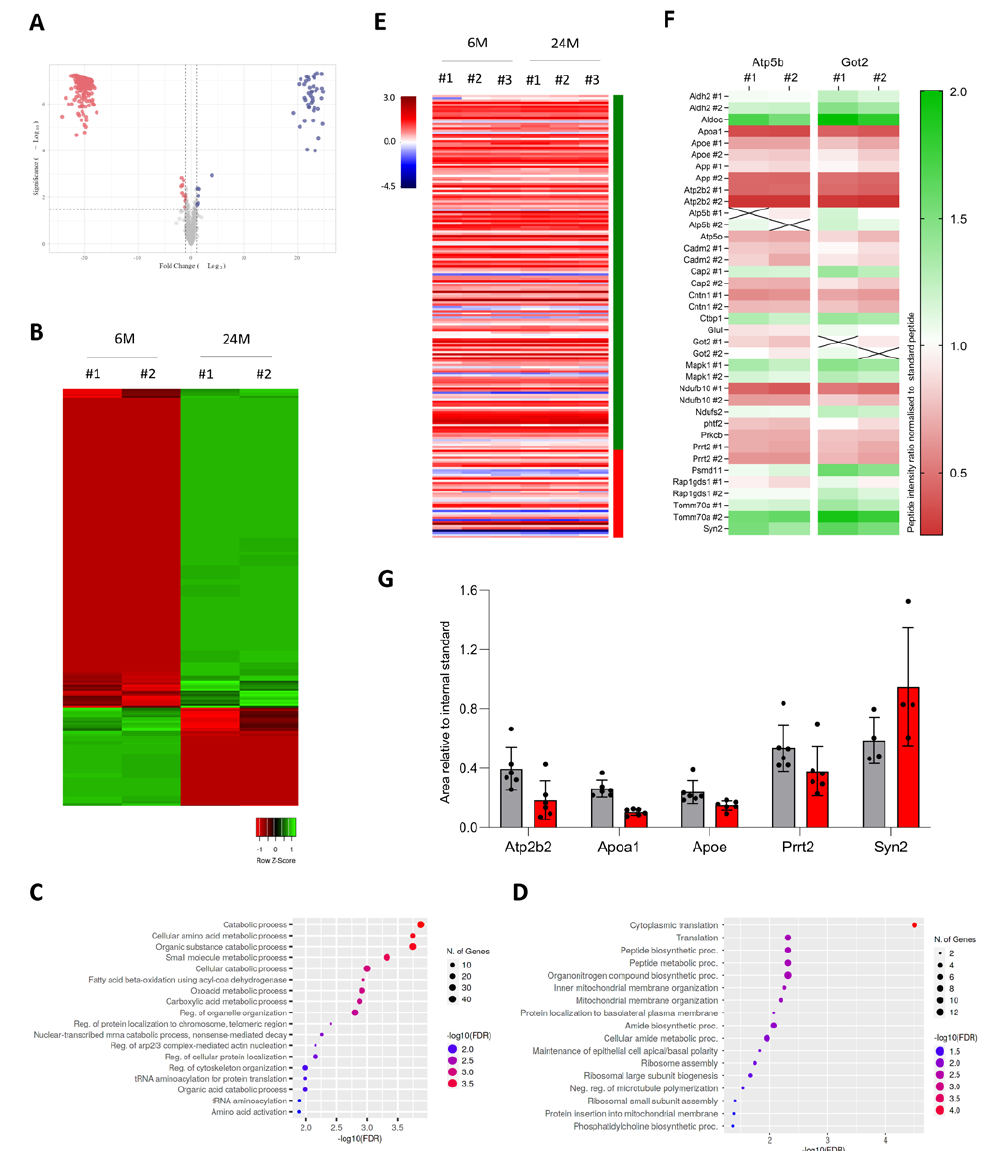
Figure 4. Age-related changes in the proteome of the cerebral cortex. ( A ) Volcano plot of the distribution of differentially enriched proteins, mapping the 164 down-regulated proteins (red) and 42 up-regulated proteins (blue). Data analysis was performed using Prostar software (log2 fold change threshold: 1, –log10 p-value: 1.3) (n = 2). ( B ) Hierarchical clustering of proteins showing significant differential enrichment in the aging cortex, based on the ratio of the area below the curve. Green and red indicate relatively high and low enrichment, with a ratio independently scaled to a mean of zero. ( C , D ) Gene Ontology analysis of proteins up-regulated ( C ) and down- regulated ( D ) in the aging cortex using the ShinyGO tool. The pathway database used was the GO Biological Process. Parameters were set at a 0.05 FDR cut-off with no redundancy in GO terms. ( E ) Heatmap of RNA transcript expression for each gene encoding differentially enriched proteins in 6 and 24-month-old cortices. Samples were independently scaled to a mean of zero. Green and red side bars indicate, respectively, up- and down-regulated proteins during cortex aging. ( F ) Heatmap of peptides quantified by PRM mass spectrometry. Each horizontal line represents one peptide. Green and red respectively indicate high and low expression. Values were based on the ratio of the area